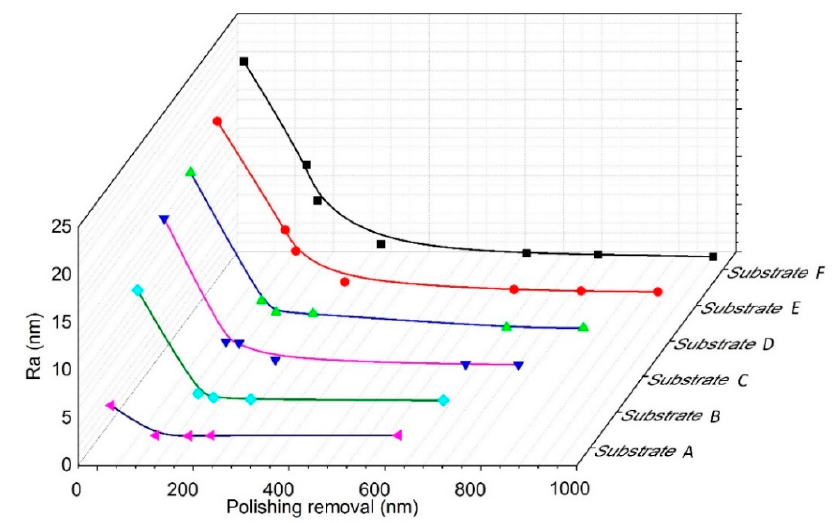
Figure 10. Roughness improvement after di ff erent removal depth by BP.